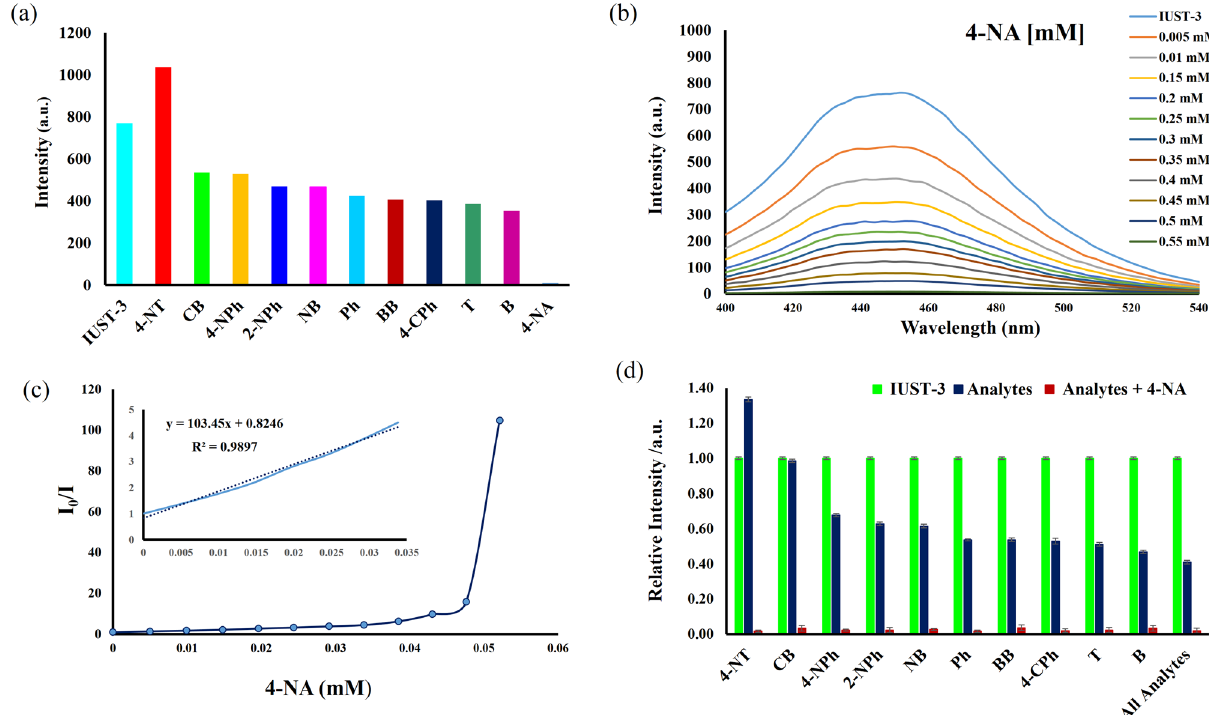
Figure 3. ( a ) The comparison of the fluorescence quenching intensity of the IUST-3 (1 mg) in water (2 ml) among the aromatic compounds (1 mM, 100 µl), ( b ) Photoluminescence spectra of the IUST-3 with gradual addition of 4-NA (1 mM, 10 µL addition each time), ( c ) Stern–Volmer plot of I 0 /I versus 4-NA concentration in the IUST-3 aqueous suspension (insert: enlarged view of a selected area), ( d ) Selective detection of 4-NA on the IUST-3 in the presence of different aromatic compounds in